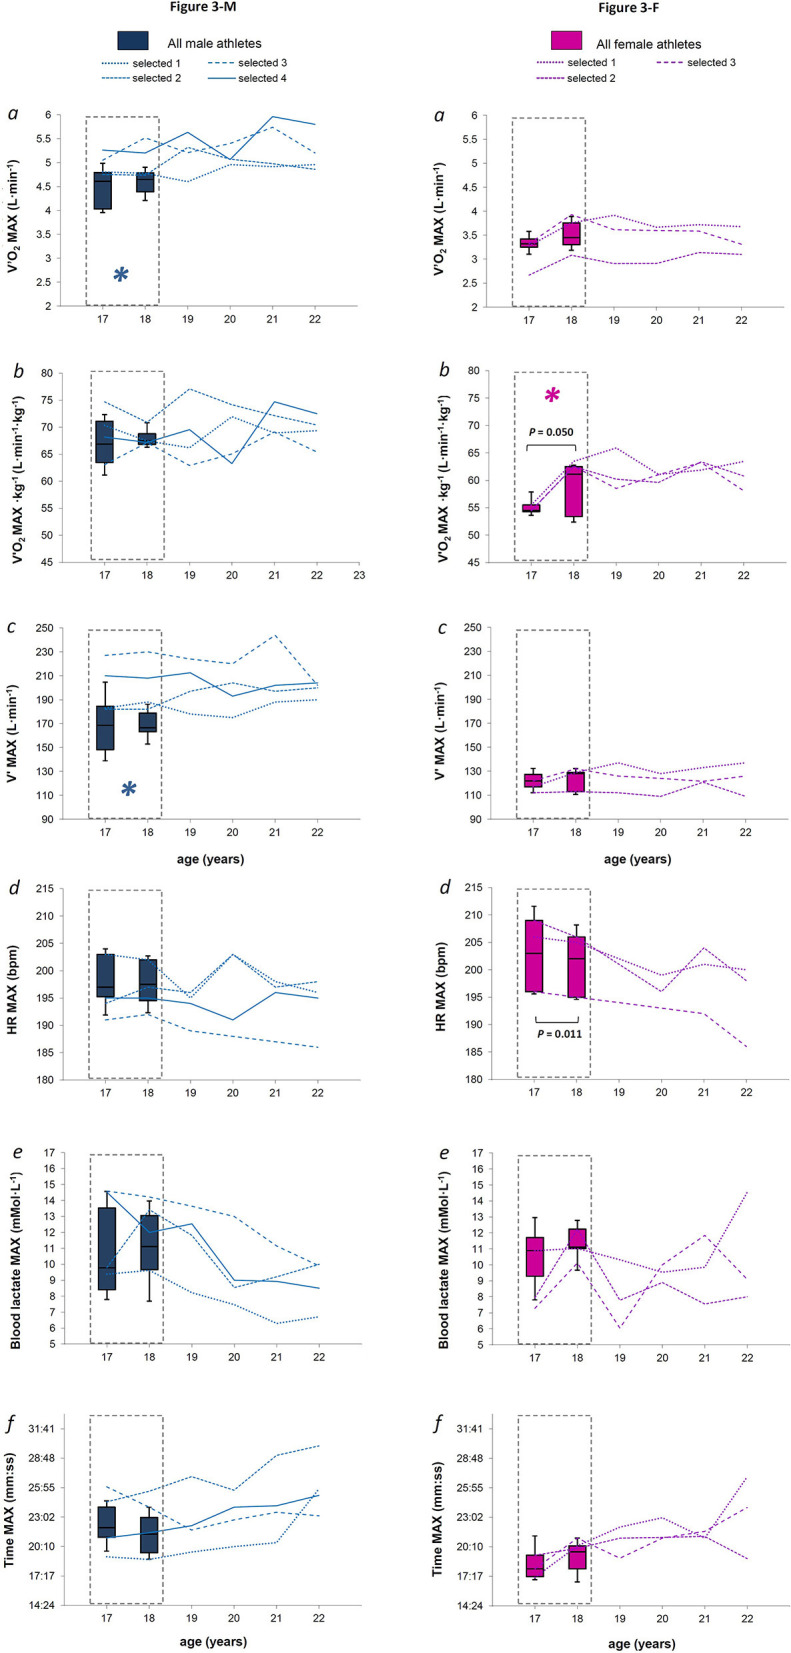
Figures 3-M and 3-F. For males and females (Figures 3-M and 3-F, respectively), the box plot represents medians, 9, 25, 75, and 90th percentiles of maximal values of absolute oxygen consumption (panel a), mass-scaled oxygen consumption (panel b), ventilation volume (panel c), absolute heart rate (panel d), blood lactate concentration (panel e), and test time (panel f) measured over the late teenage period (data in dotted-lined boxes) in the entire group. The P-value refers to the statistical age effect during the late teenage period. In each panel, the line plots represent each selected athlete from 18 to 22 years of age. *indicates possible parameters early identifying further athletes' selection, when all the criteria presented in the statistical analysis paragraph were satisfied.